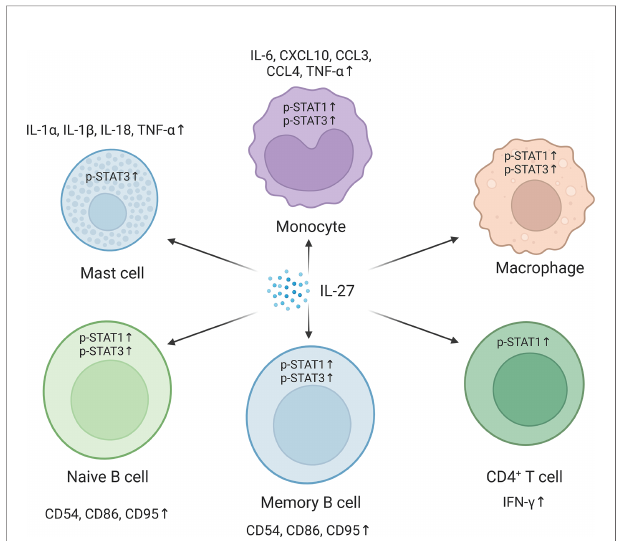
FIGURE 2 | Pathways in different cells are activated in respond to the interleukin-27 (IL-27) signaling. IL-27 signaling activates signal transducer and activator of transcription 1 (STAT1) and/or STAT3 and regulates downstream gene expression. In mast cells, IL-27 signaling upregulates IL-1 a , IL-1 b , IL- 18, and tumor necrosis factor- a (TNF- a ) by activating STAT3. IL-27 promotes the phosphorylation of STAT1 and STAT3 in monocytes and macrophages and induces the expression of IL-6, C – X – C motif chemokine 10 (CXCL10), C – C motif chemokine ligand 3 (CCL3), CCL4, and TNF- a in monocytes. In naive and memory B cells, IL-27 promotes the phosphorylation of STAT1 and STAT3 and the expression of CD54, CD86, and CD95. IL-27 also improves CD4 + T helper type 1 (Th1) polarization of CD4 + T cells by increasing STAT1 phosphorylation. The fi gure was created with